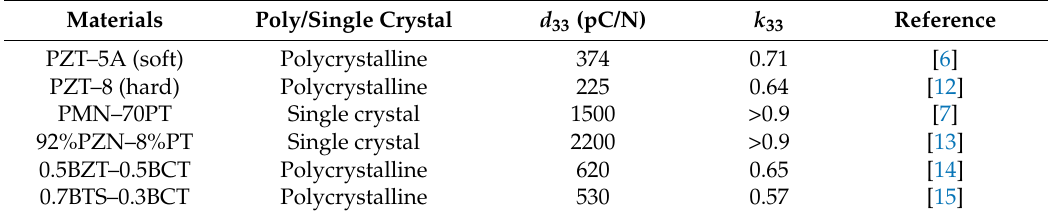
Table 1. Piezoelectric properties of Pb-based systems and BaTiO 3 based